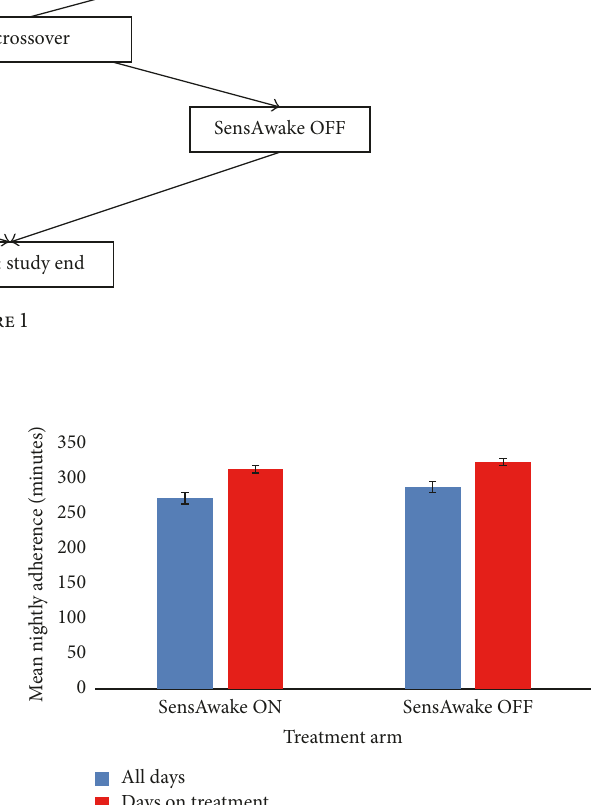
Figure 2: Adherence to CPAP devices with and without